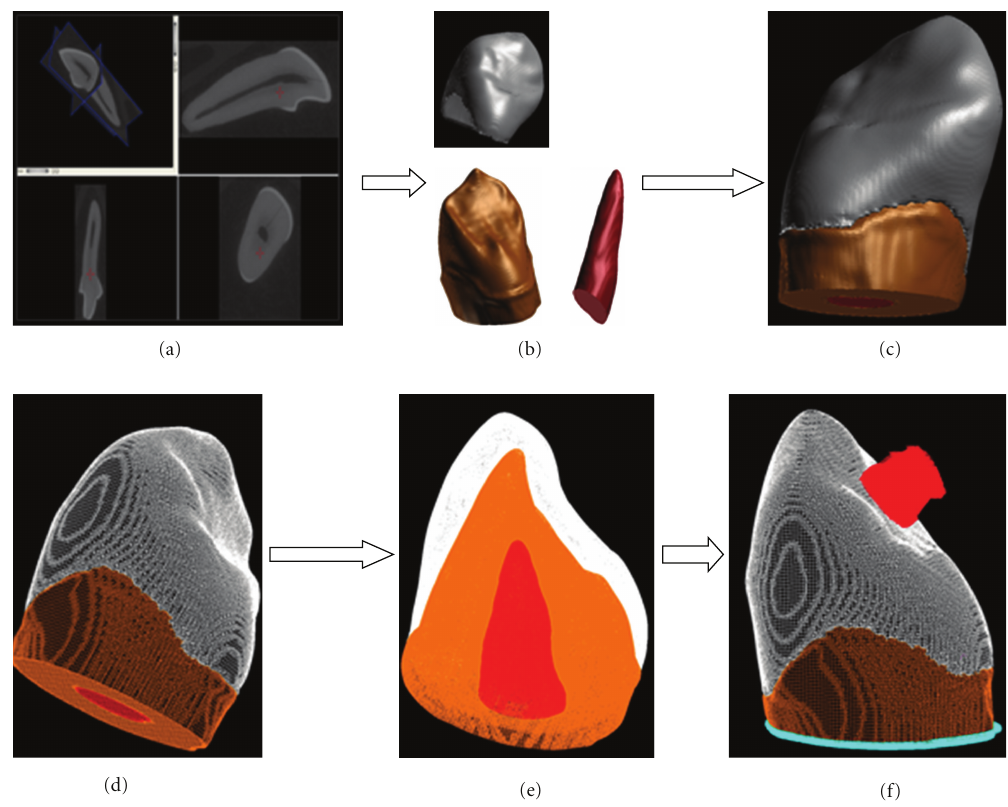
Figure 1: micro-CT imaging, modeling, and developing FE model of a canine tooth; (a) section of micro-CT; (b) segmentation and 3D reconstruction of tooth tissues; (c) 3D model of canine tooth; (d) FE mesh of 3D model; (e) assignment of di ff erent materials properties; (f) boundary conditions and lateral loading on 3D-FE model.